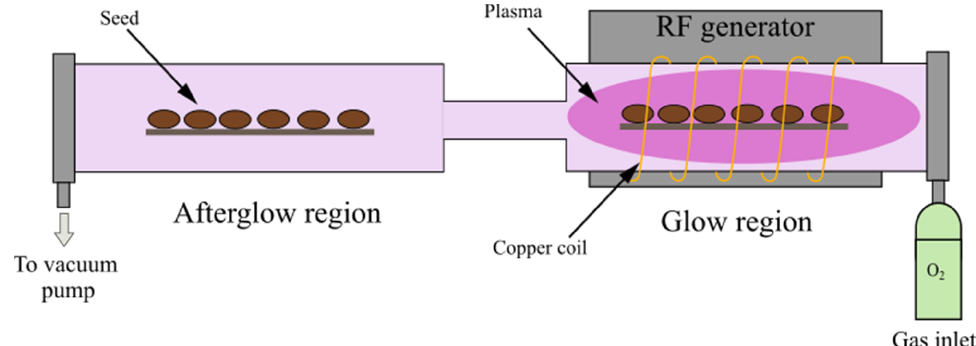
Figure 11. A schematic representation of the plasma reactor used in the experiment.